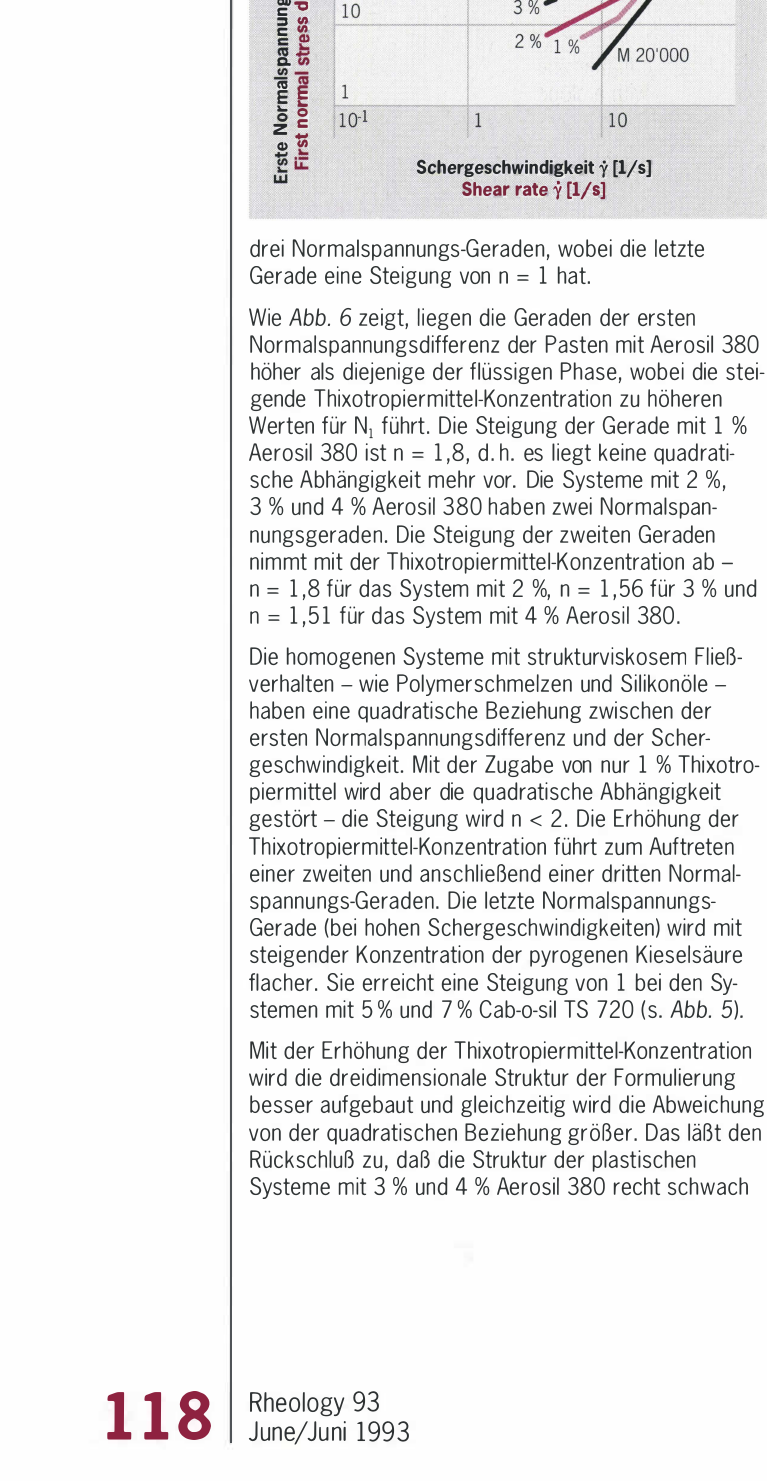
Abb. 6: Abhiingigkeit der ersten Normalspannungsdiffe­ renz von der Schergeschwin­ digkeit Fig. 6: Dependence of the first normal stress difference on shear rate.